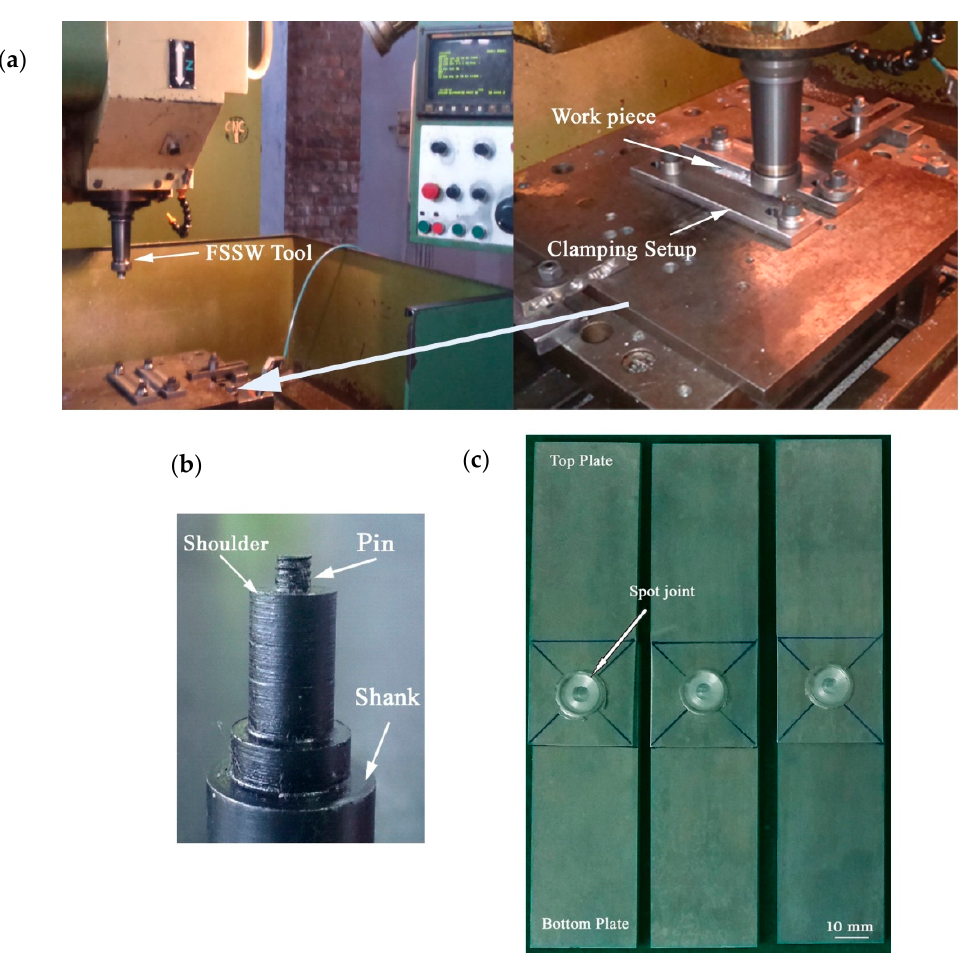
Figure 3. ( a ) FSSW setup. ( b ) FSSW tool used for the experiments. ( c ) Fabricated spot-weld Table 2. Characteristics of the FSSW tool. Table 2. Characteristics of the FSSW tool.